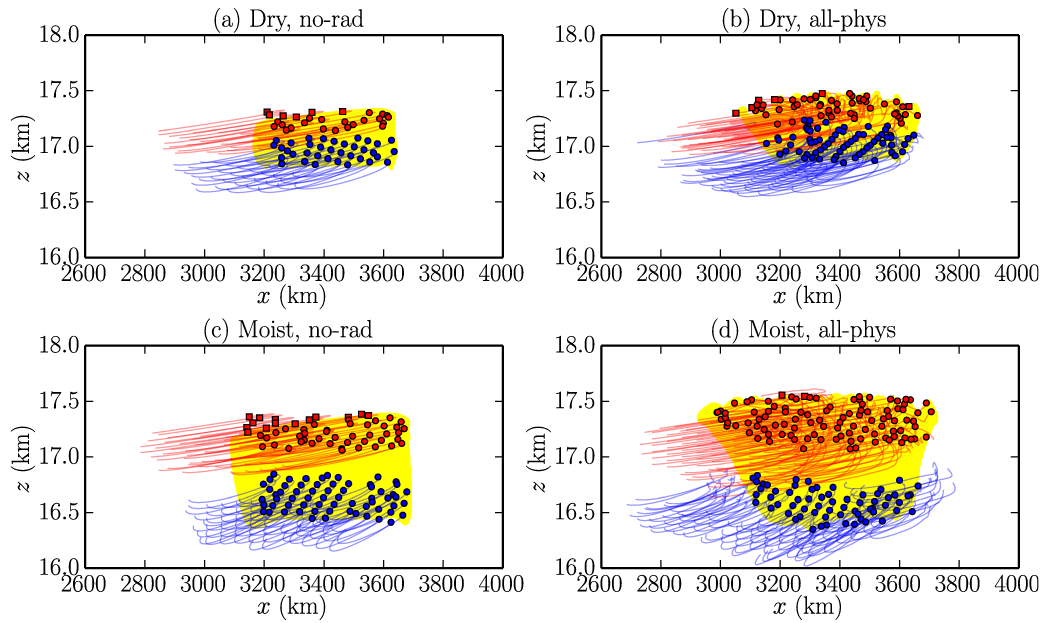
Figure 6. The cloud at t = 3 . 5d (yellow-shaded region) and representative air parcel trajectories from t = 0 to 3 . 5d in the no-rad (left column) and all-phys (right column) simulations for the dry (top row) and moist (bottom row) scenarios. Trajectories of dehydrated and hydrated air parcels are shown in red and blue respectively. The locations of the parcels at 3 . 5d are marked with circles if the parcels are inside the cloudy region, and with squares if the parcels passed through the cloud at earlier times and are in cloud-free air at 3 . 5d. Some parcels (whose locations at 3 . 5d are not indicated by squares or circles) have not entered the cloud (but will do so after 3 .